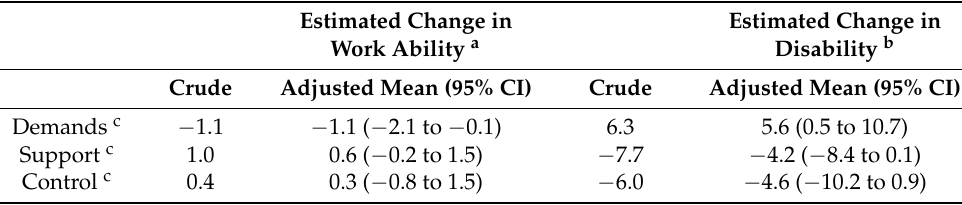
Table 3. Associations between the mean scores of the demands, support and control dimensions at work and work ability and disability during physiotherapy treatment (measured at baseline, 3 and 9 months). Estimates reflect changes in the outcome variable per unit increase of the demand, support and control